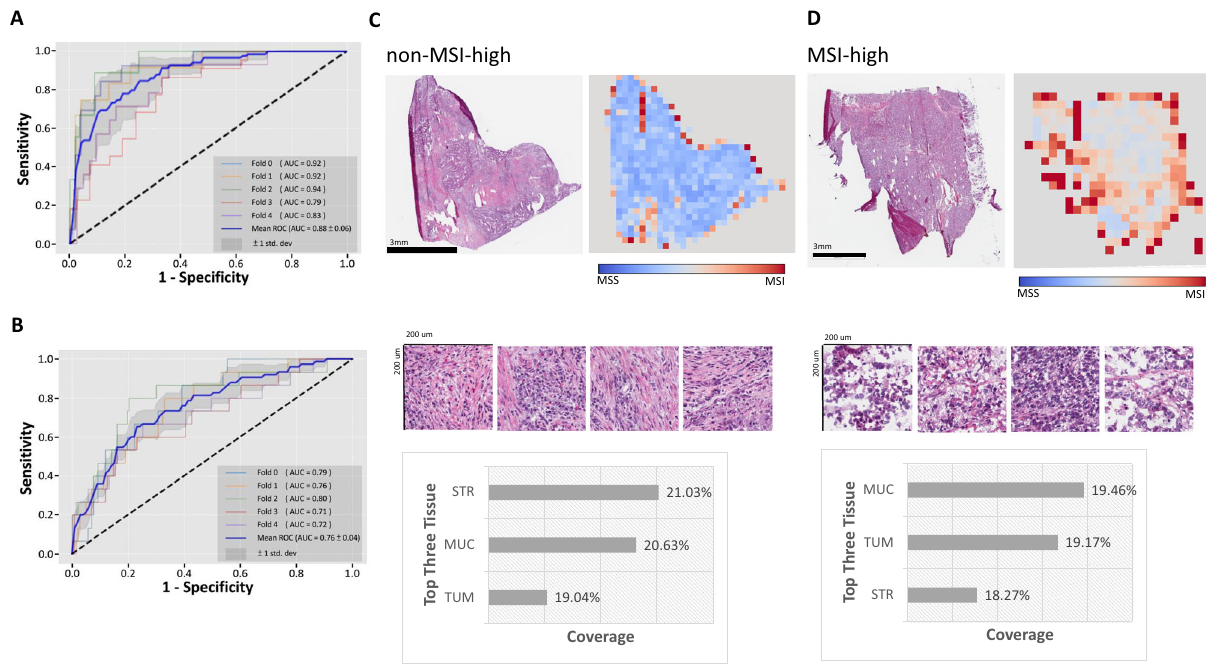
Fig. 6 | MOMA predicts MSI status in colorectal cancer patients. A Our MSI prediction model achieves an area under the receiver operating characteristic curve (AUC) of 0.88 in the TCGA held-out test set. B Our MSI prediction model is further validated in the Nurses ’ Health Study and Health Professionals Follow-up Study cohorts (AUC=0.76). C Attention visualization of a pathology image with non-MSI-high cancer. Informative regions of cancer-associated stroma, cancer